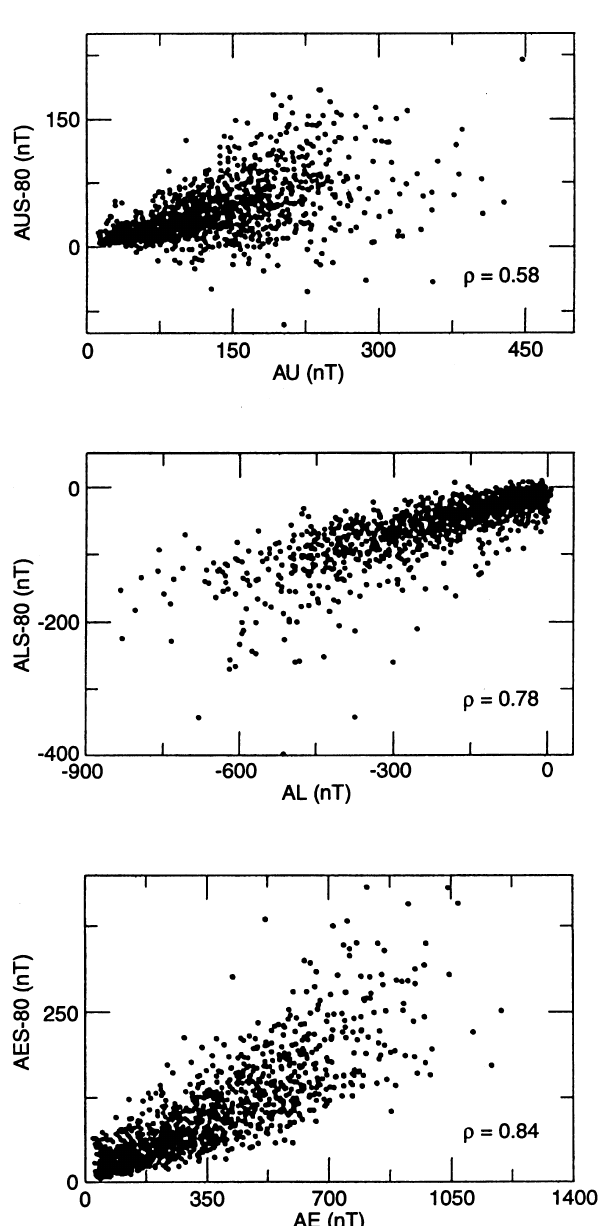
Fig. 2. Scatter plots for AUS-80 and AU ( top panel ), ALS-80 and AL ( middle panel ), AES-80 and AE ( bottom panel ). The number of data points is always N = 1385 (hourly values are used in this case) and the correlation coe(cid:129)cient ( q ) is indicated for each panel